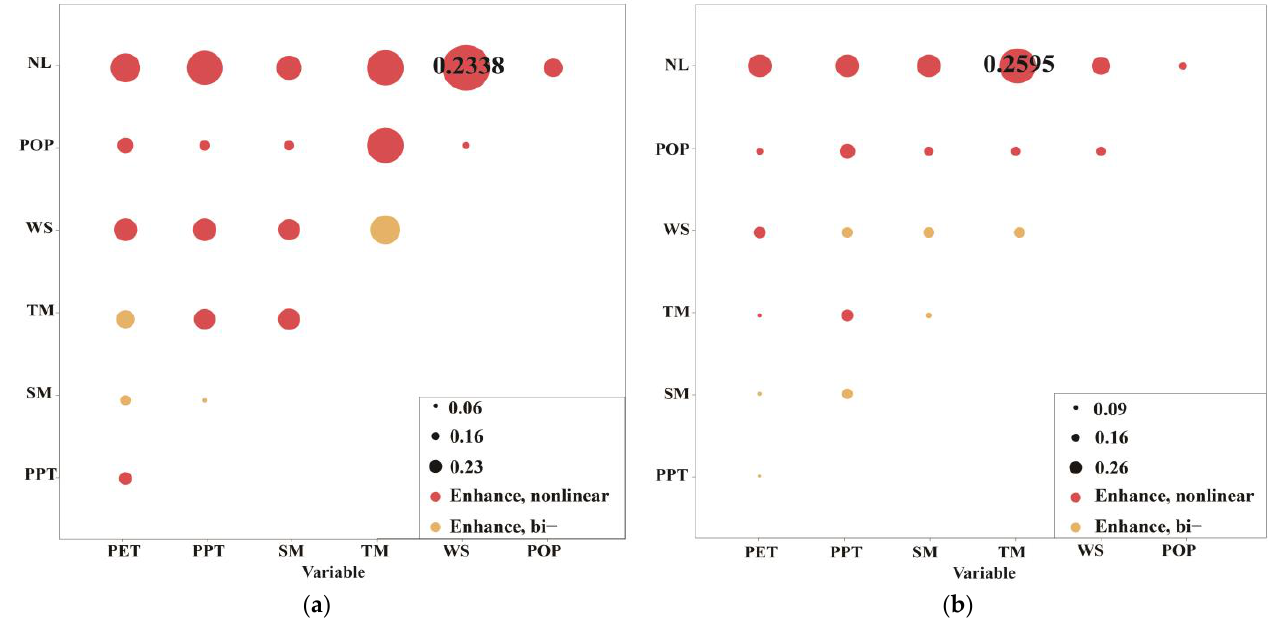
Figure 11. Interaction results of desertification drivers in the study area. ( a ) East Ujimqin Banner, ( b ) the three counties in Mongolia.